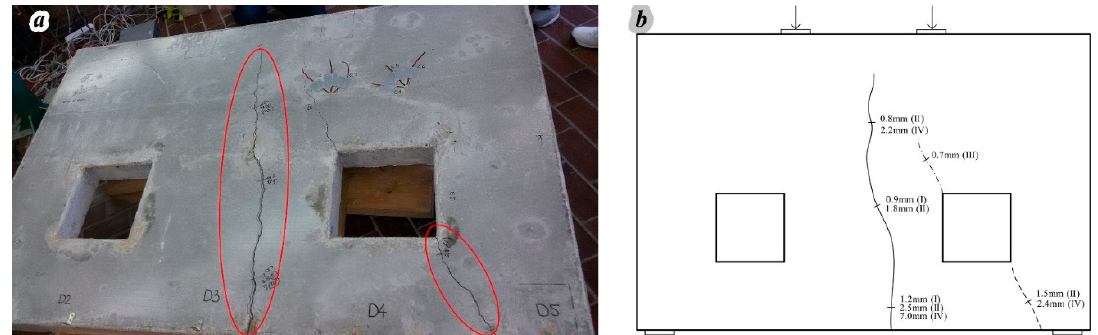
Figure 19. Crack and failure pattern: ( a ) tested member W1 at maximum load, ( b ) schematic view. Appl. Sci. 2020 , 10 , x FOR PEER REVIEW